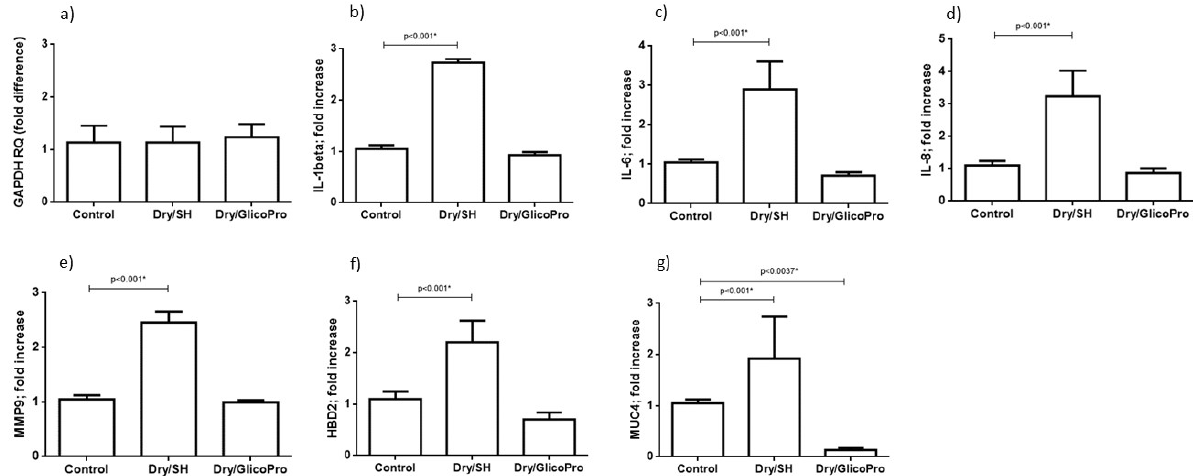
Figure 3. Quantitative reverse transcription polymerase chain reaction. Quantitative reverse transcription polymerase chain reaction results of ( a ) GAPDH, ( b ) interleukin (IL)-1 beta, ( c ) IL-6, ( d ) IL-8, and ( e ) matrix metallopeptidase-9 (MMP9), ( f ) defensin β -2 (DEFB2), ( g ) mucin (MUC)4 levels in corneal tissues under normal conditions (37 °C) and dry eye conditions (Dry) wit sodium hyaluronate 0.15% (SH) or with GlicoPro treatments. The results are expressed as the mean of triplicate experiments after 24 h of treatment. The data are presented as mean ± standard deviation. * significative p value.